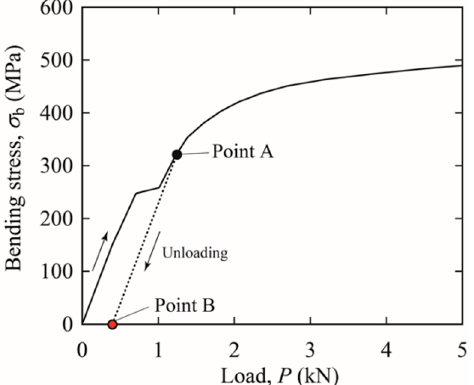
Figure A2. Relationship between load, P , and bending stress, σ b , at the specimen edge obtained based on FEA.